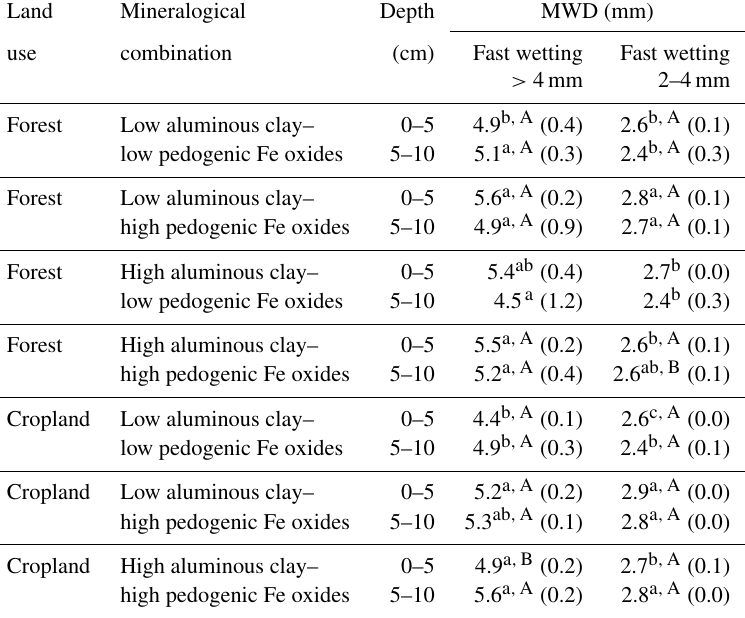
Table 3. Aggregate stability of selected aggregate size fractions after applying the fast-wetting procedure along the different combinations of aluminous clay and pedogenic Fe oxides, indicated by the resulting mean weight diameter (MWD). Aluminous clay represents the weight sum of kaolinite and gibbsite present in the < 2µm fraction after removal of OM and pedogenic Fe oxides. Lowercase letters indicate significant differences within a certain land use separated by depth, and capital letters denote significant differences between land uses. Sample numbers for the combinations are as follows: “low clay–low Fe” under forest ( n = 4), “low clay–high Fe” under forest ( n = 4), “high clay–low Fe” under forest ( n = 3), and “high clay–high Fe” under forest ( n = 7), with all cropland combinations ( n =